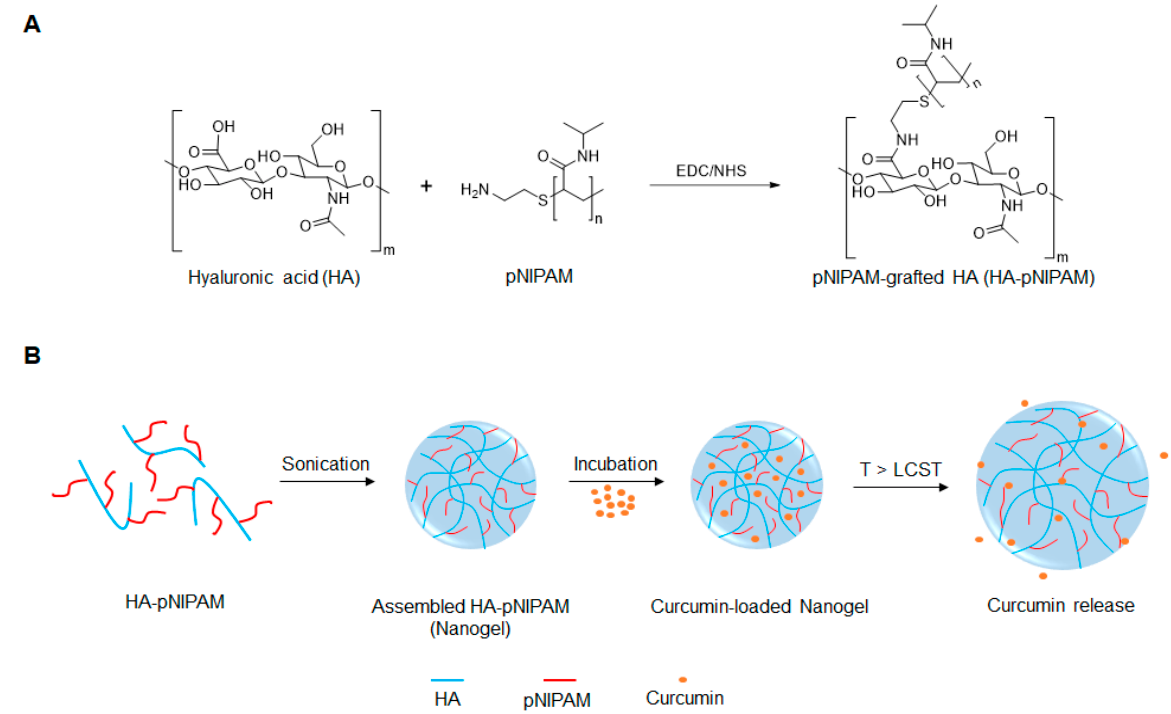
Figure 1. Schematic representation of ( A ) the preparation of pNIPAM-grafted hyaluronic acid (HA-pNIPAM) and ( B ) the assembly of HA-g- pN nanogel and curcumin release.